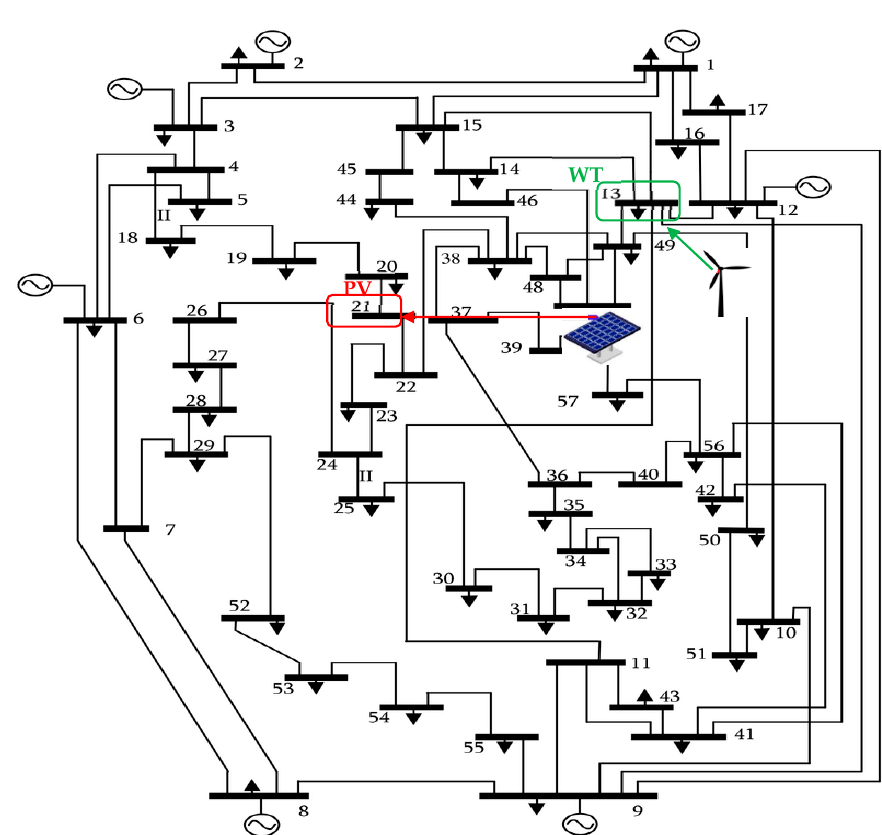
Figure A1. Single-line diagram of the IEEE 57-bus system.